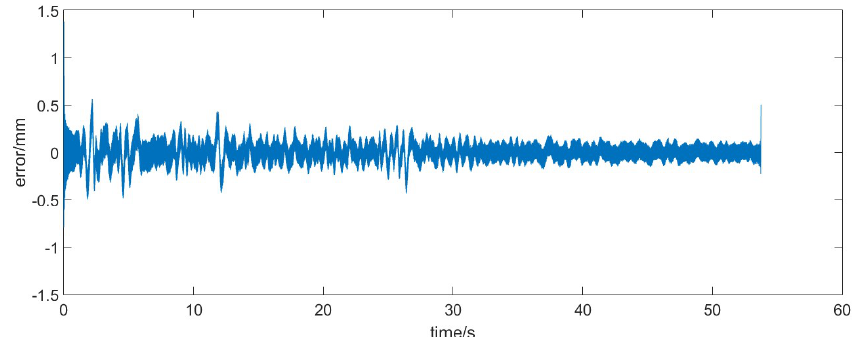
Figure 7. The real data and measurement